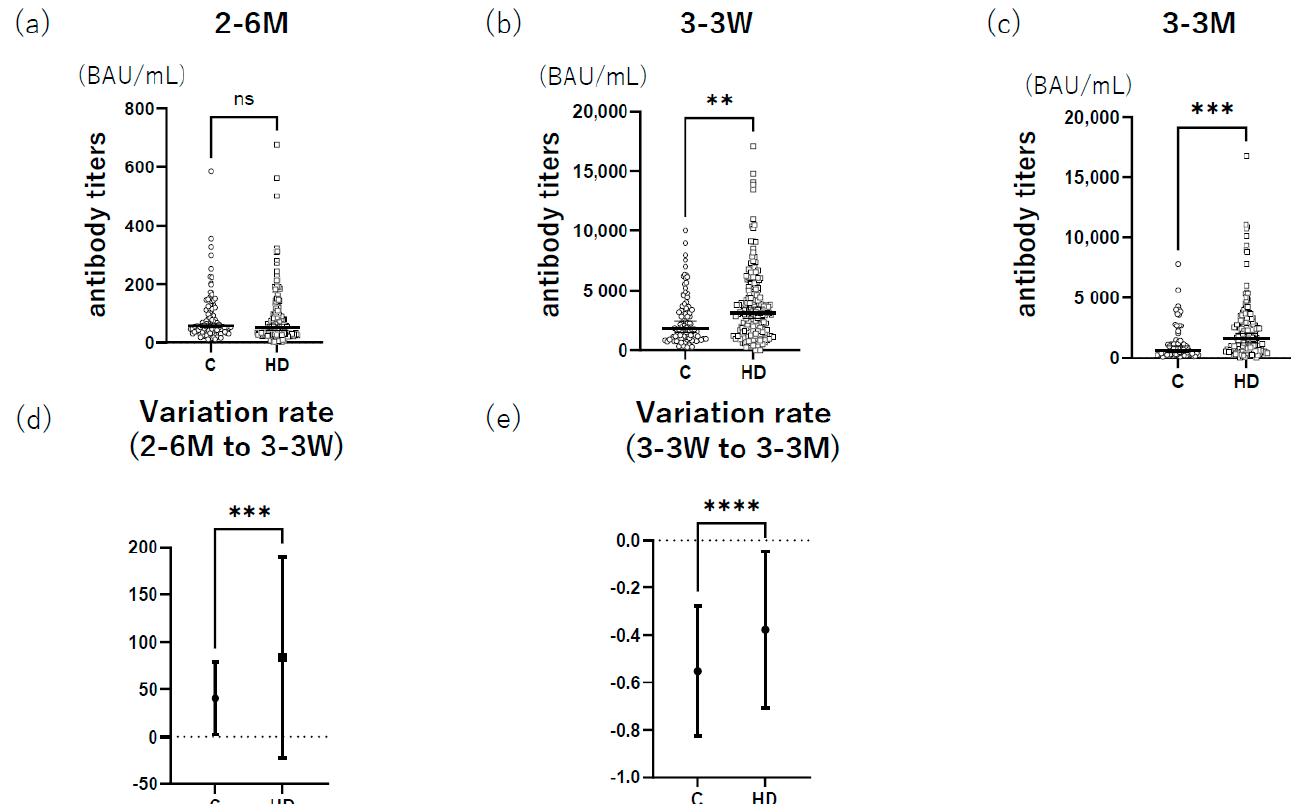
Figure 2. Comparison of antibody titers between the control and HD groups. Antibody titers in the control and HD groups were compared at three time points: ( a ) 6 months after the primary series (control group, n = 103; HD group, n = 194); ( b ) 3 weeks after the booster dose (control group, n = 97; HD group, n = 182); and ( c ) 3 months after the booster dose (control group, n = 82; HD group, n = 176). The variations from 6 months after the primary series to 3 weeks after the booster dose ( d ) and from 3 weeks after the booster dose to 3 months after the booster dose ( e ) were compared. Variations were calculated as follows: ( d ) (value at 3 weeks after the third vaccine–value at 6 months after the primary series)/value at 6 months after the primary series and ( e ) (value at 3 months after the third vaccine–value at 3 weeks after the third vaccine)/value at 3 weeks after the third vaccine. Bars indicate the median with a 95% confidence interval ** p ≤ 0.01, *** p ≤ 0.001, **** p ≤ 0.0001. 2–6 M: 6 months after the primary series; 3–3 W: 3 weeks after the booster dose; 3–3 M: 3 months after the booster dose; C: control; HD: Hemodialysis.